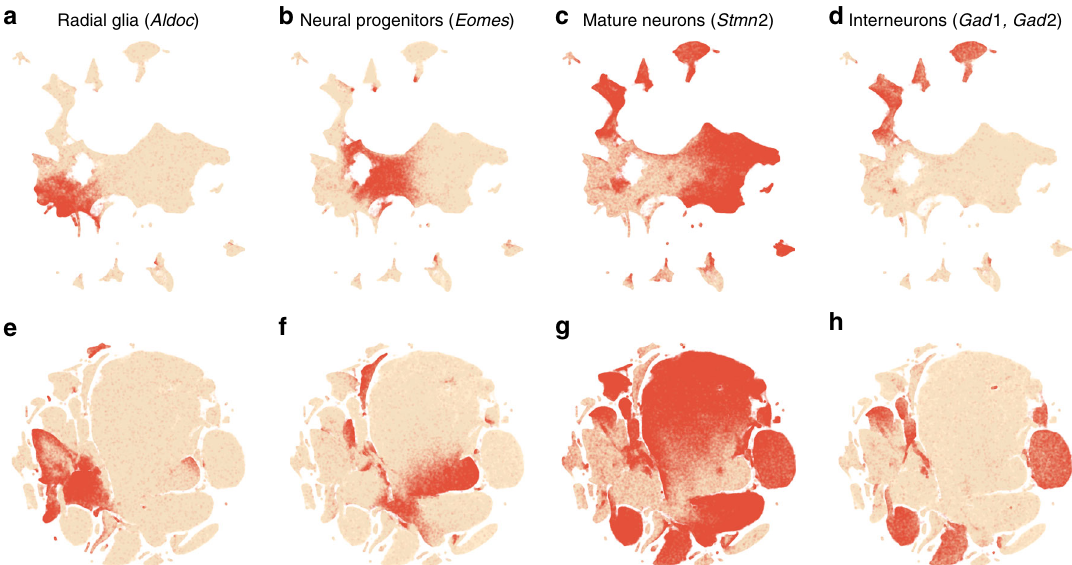
Fig. 8 Developmental marker genes. Overlay over t-SNE embeddings from Fig. 7. a Expression of Aldoc gene (marker of radial glia) on the t-SNE embedding from Fig. 7b. Any cell with Aldoc detected (UMI count above zero) was coloured in red. Another radial glia marker, Slc1a3 , had similar but a bit broader expression. b Expression of Eomes , marker of neural progenitors (neuroblasts). c Expression of Stmn2 , marker of mature neurons. A pan-neuronal marker Tubb3 had similar but a bit broader expression. d Expression of Gad1 and Gad2 (either of them), markers of inhibitory neurons. e – h The same genes overlayed over the default t-SNE embedding from Fig. 7e.